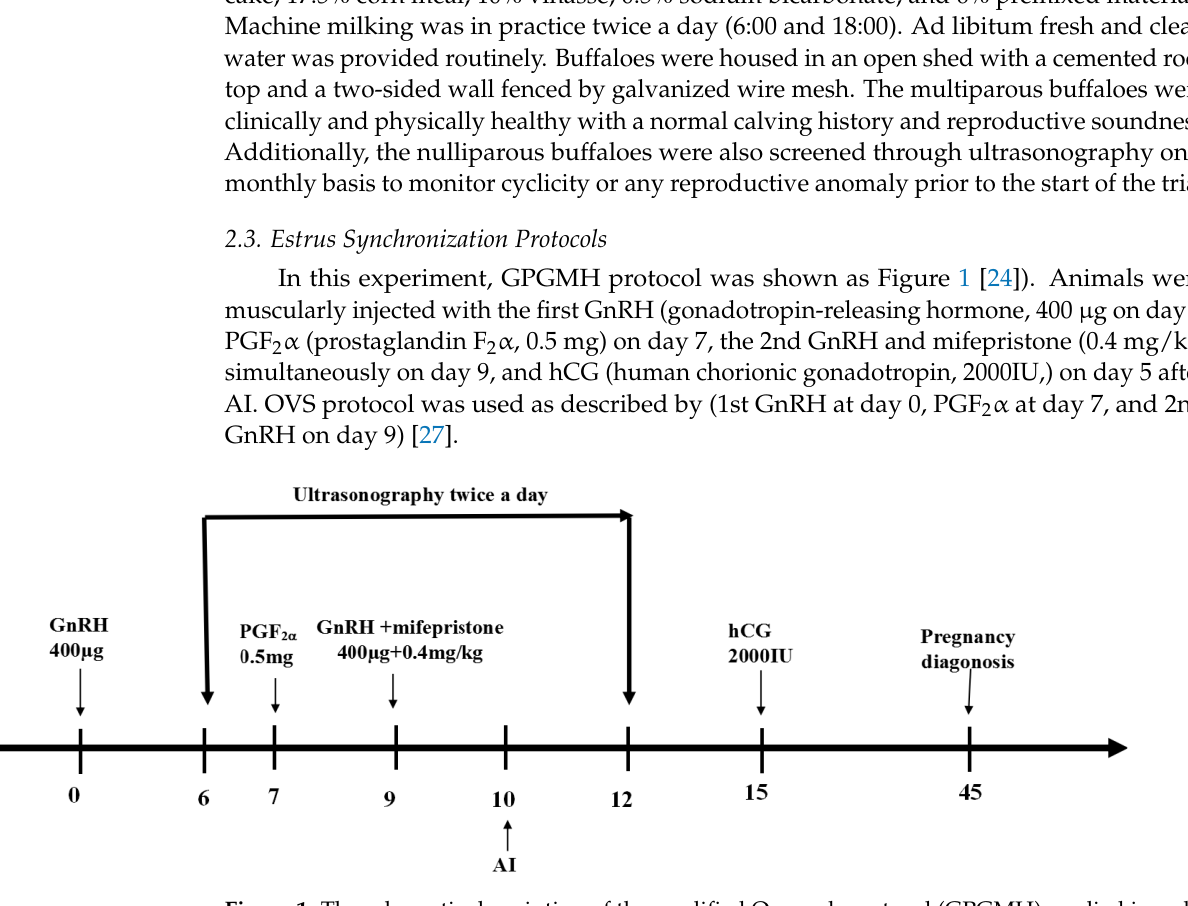
Figure 1. The schematic description of the modified Ovsynch protocol (GPGMH) applied in nulliparous and multiparous buffaloes during peak and low breeding seasons [24].